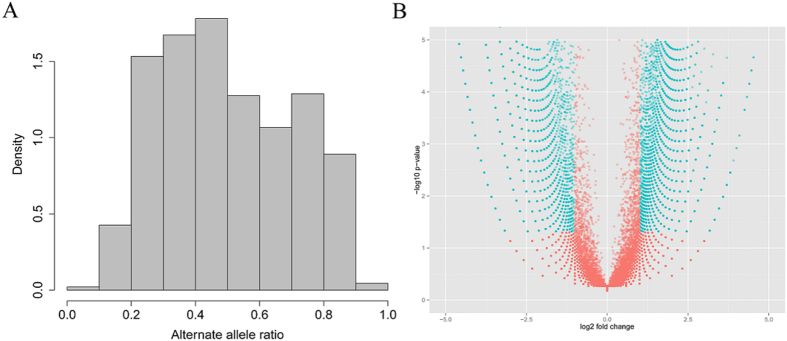
Allele-specific expression analysis of heterozygous SNPs in porcine prenatal skeletal muscle.(A) Distribution of the alternate allele ratio for all heterozygous sites expressed in prenatal porcine skeletal muscle. (B) Volcano plot analysis of heterozygous SNPs with allelic imbalance. The blue points are SNPs showing significant ASE, whereas red points are SNPs with no significant ASE.